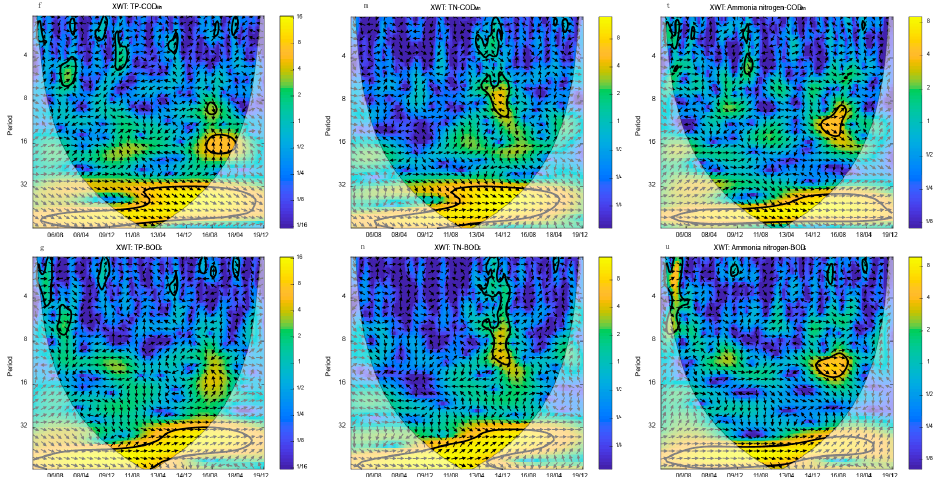
Figure 6. Cross wavelet transform (XWT) of the nutrient concentration. The thick black contour indicates a 95% confidence level against yellow noise and the cone of influence is shown as the lighter shade. The arrows (vectors) designate the phase difference (within–phase pointing right, anti-phase pointing left). The arrow to the left indicates negative phase coherence, and again the darker the color, the stronger the negative coherence. Y -axis period is month, the X -axis date format is year/month. ( a – g ) are XWT of TP and Temperature, pH, Flow, EC, DO, COD Mn , and BOD 5 . ( h – n ) are XWT of TN and Temperature, pH, Flow, EC, DO, COD Mn , and BOD 5 . ( o – u ) are XWT of –N and Temperature, pH, Flow, EC, DO, COD Mn , and BOD 5 NH + 4